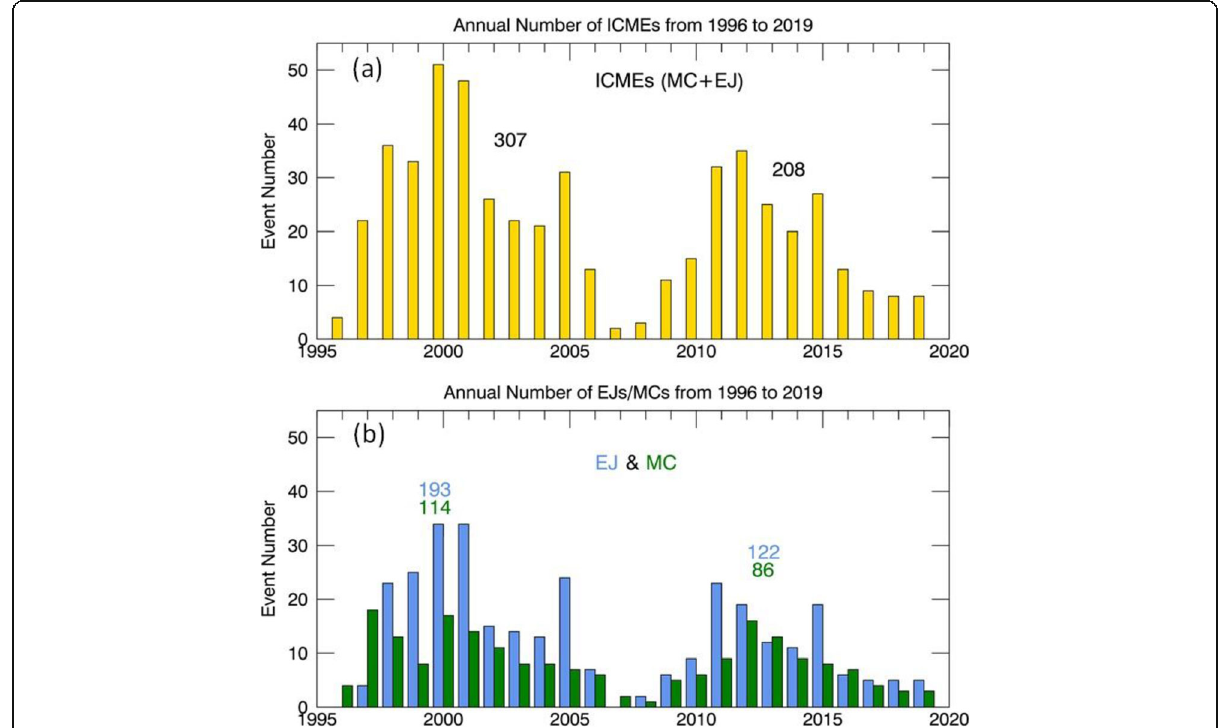
Fig. 7 a Solar cycle variation of the annual number of ICMEs (magnetic clouds — MCs and non-cloud ejecta — EJs) observed near Earth as compiled in http://www.srl.caltech.edu/ACE/ASC/DATA/level3/icmetable2.htm. The total number of ICMEs in cycles 23 (307) and 24 (208) are noted on the plot. b Annual number of EJs and MCs shown separately. The number of EJs and MCs is noted on the